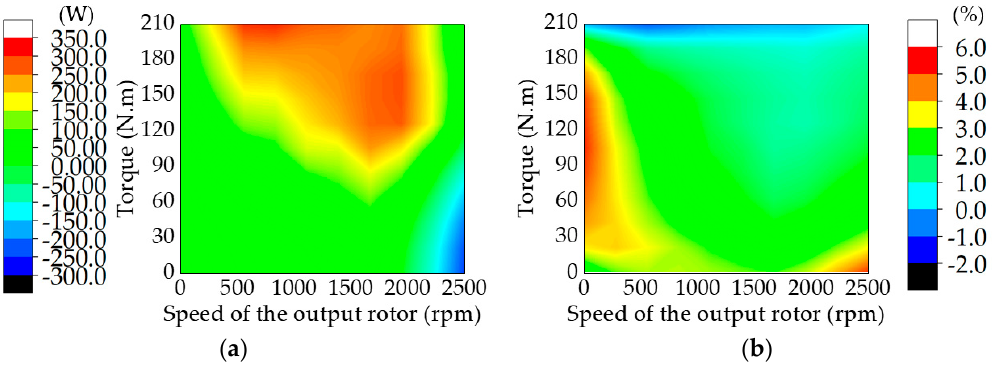
Figure 11. Loss and efficiency maps. ( a ) Iron loss difference between minimum iron loss maps of the inner-armature case and outer-armature case; ( b ) Efficiency difference between maximum efficiency maps of the inner-armature case and outer-armature case.